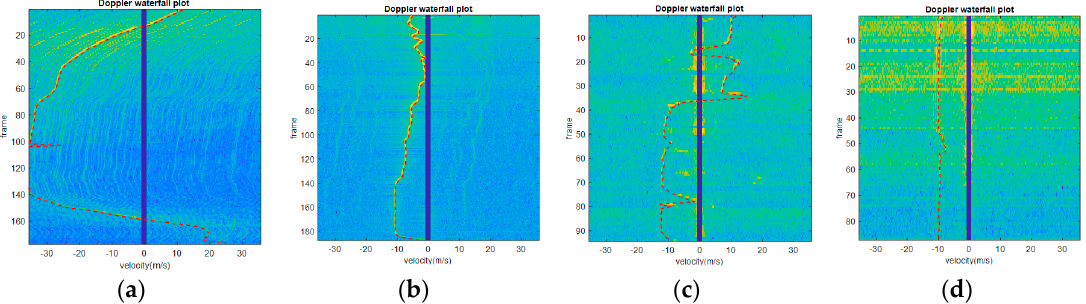
Figure 16. The measured Doppler waterfall plots. ( a ) Helicopter. ( b ) Rotary-wing UAV. ( c ) Fixed-wing UAV. ( d ) Bird.